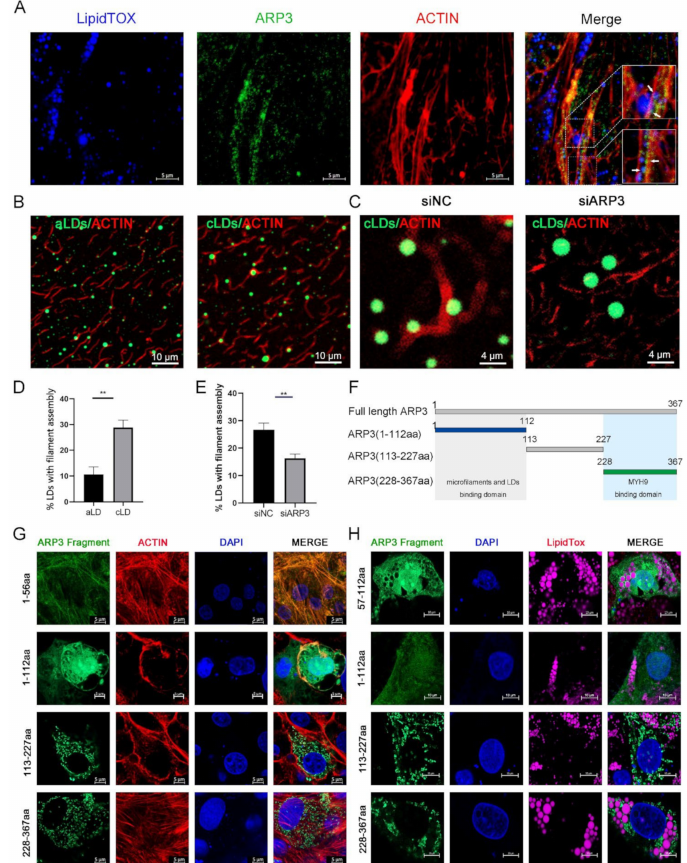
Figure 1. ARP3 localized on microfilaments and Lipid droplets (LDs). ( A ) Subcellular localization of ARP3 and LDs, bar, 10 µ m. Arrow:co-location between LDs, Arp3, and microfilaments. ( B ) The binding of artificial LDs (aLDs) or intracellular LDs (cLDs) and actin, bar, 10 µ m. ( C ) The binding of isolated intracellular LDs (cLDs) and actin after being treated with siNC or siARP3, bar, 4 µ m. ( D ) The Quantitative Analysis of LDs binding with microfilaments of ( B ), ** p < 0.01. ( E ) The Quantitative Analysis of LDs binding with microfilaments of ( C ), ** p < 0.01. ( F ) Schematic diagram of ARP3 truncation fragments. ( G ) Subcellular localization of ARP3 truncation fragments and microfilament, bar, 5 µ m. ( H ) Subcellular localization of ARP3 truncation fragments and LDs, bar, 5 µ